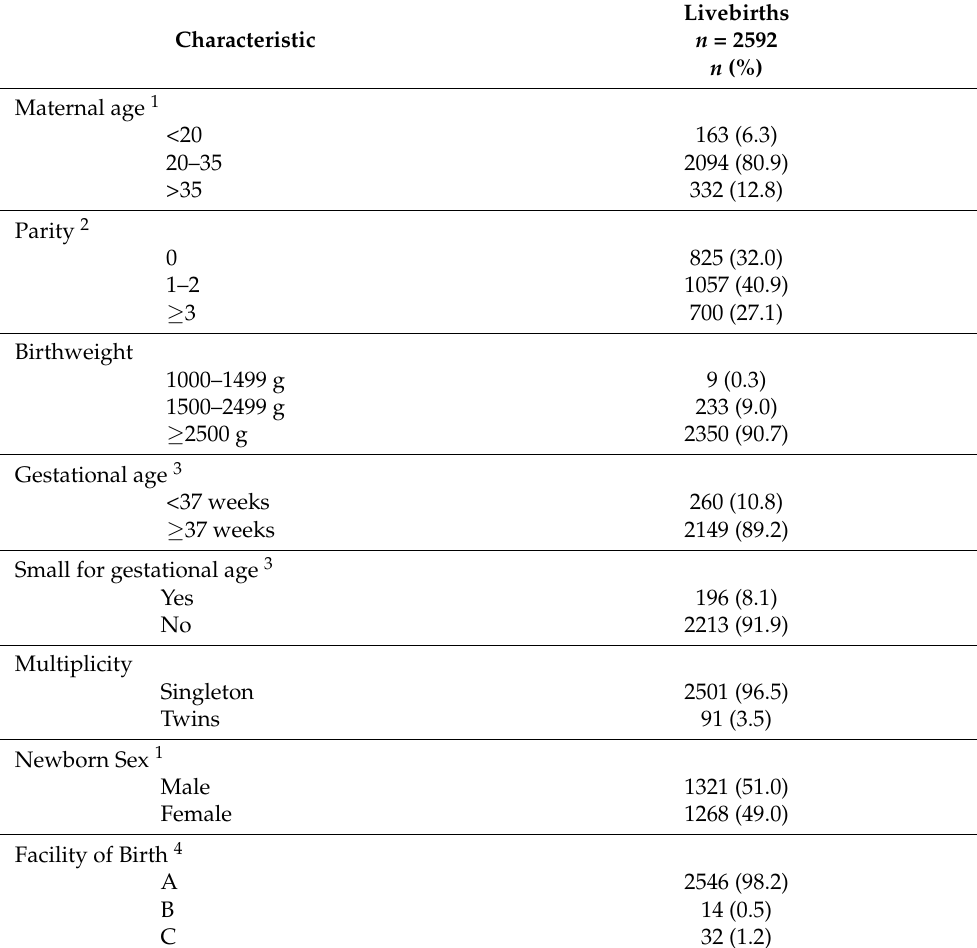
Table 2. Demographic characteristics of